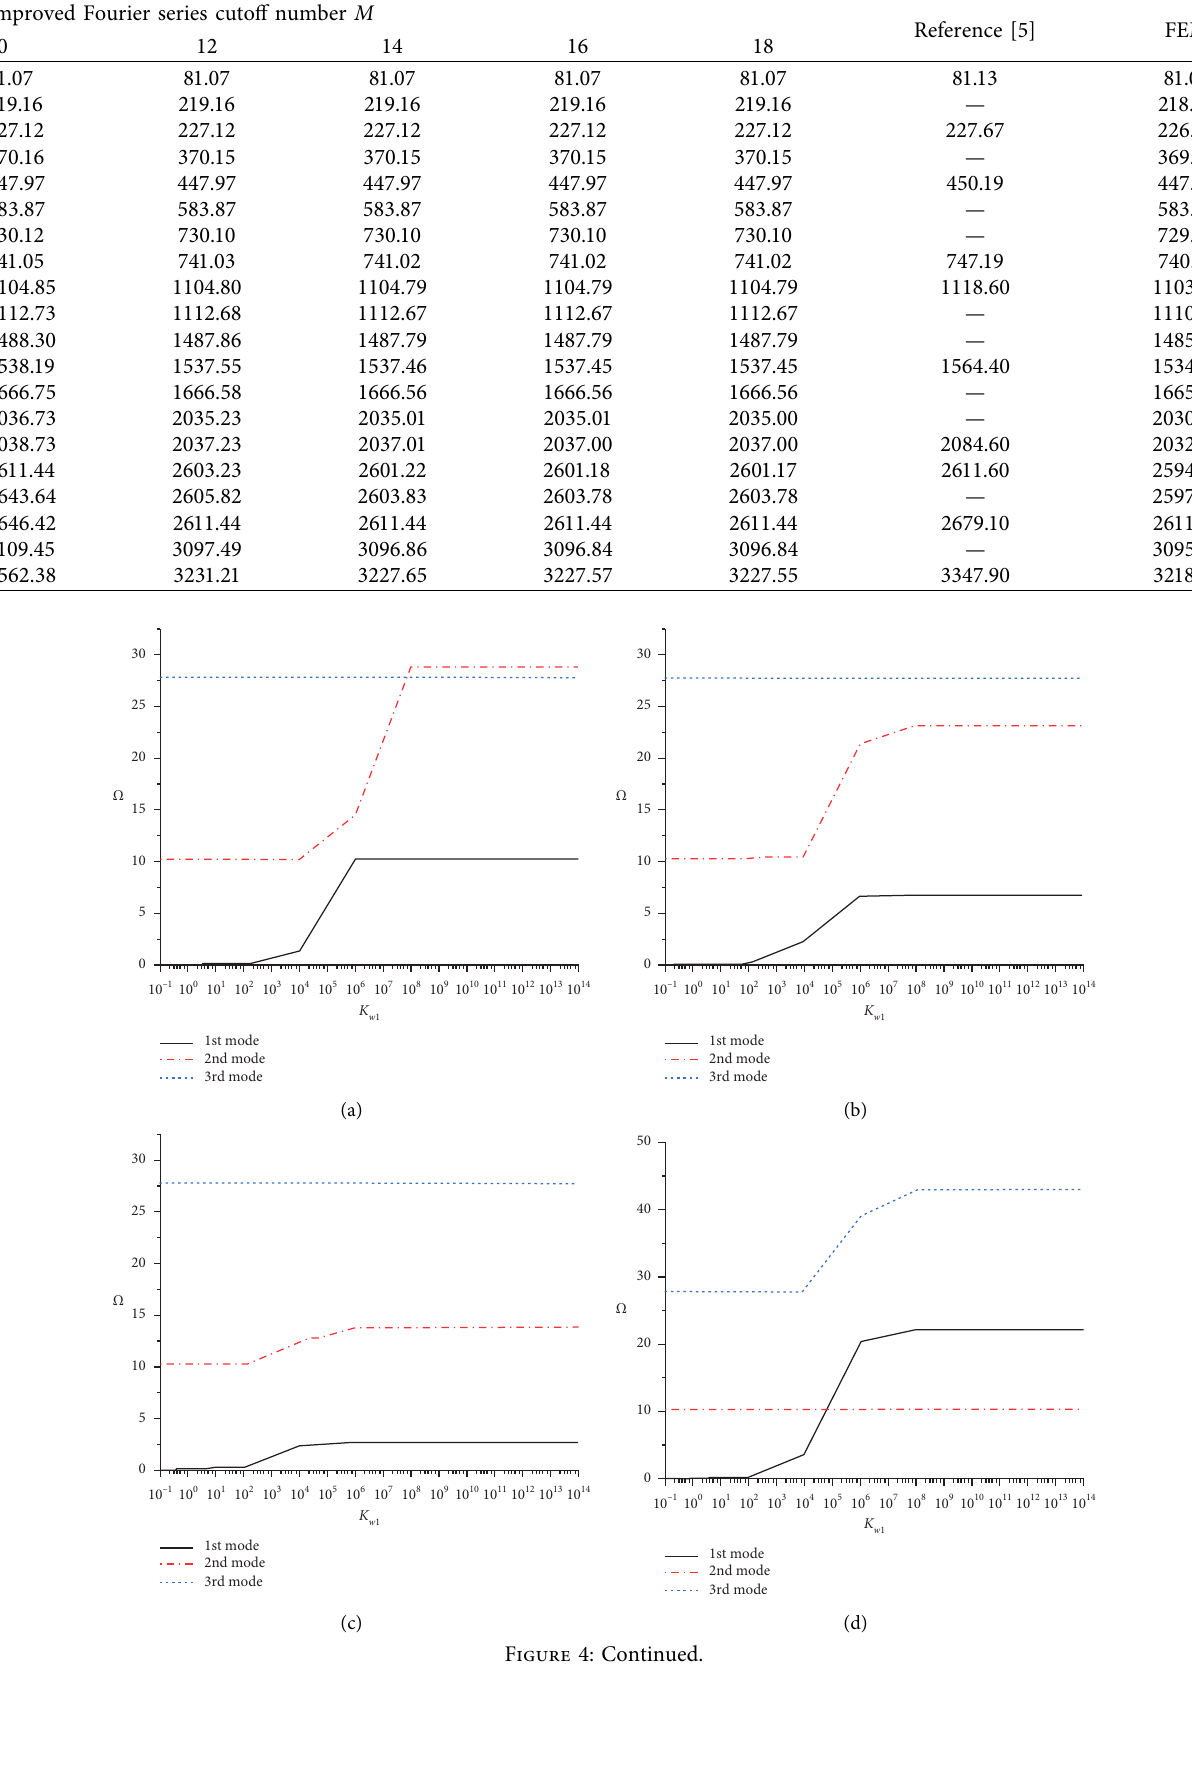
Table 1: Improved Fourier series convergence and accuracy (unit